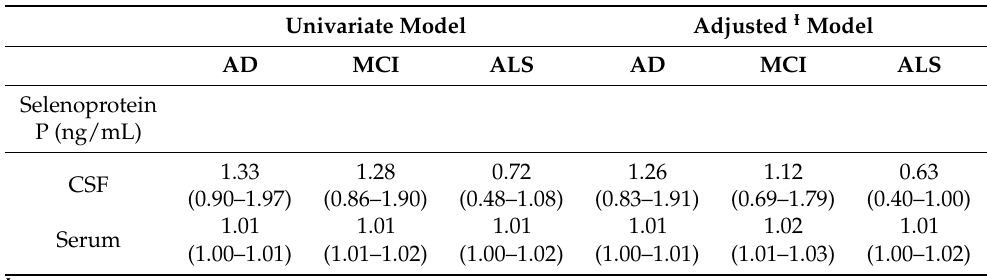
Table 1. Cerebrospinal fluid (CSF) and serum levels of selenoprotein P and CSF levels of selenoprotein-P-bound selenium, amyloid-beta and phosphorylated and total tau in relation to